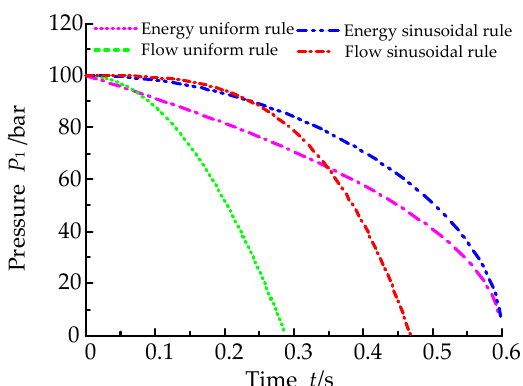
Figure 5. The simulation curve of working cylinder pressure under the different pressure-relief rules.